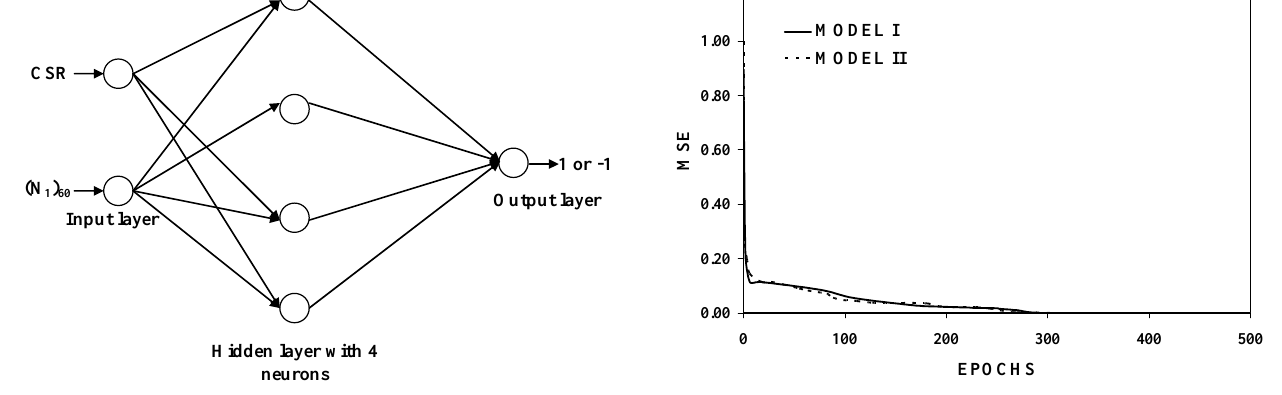
Figure 2. ANN architecture for MODEL I. Fig. 2. ANN architecture for MODEL I.